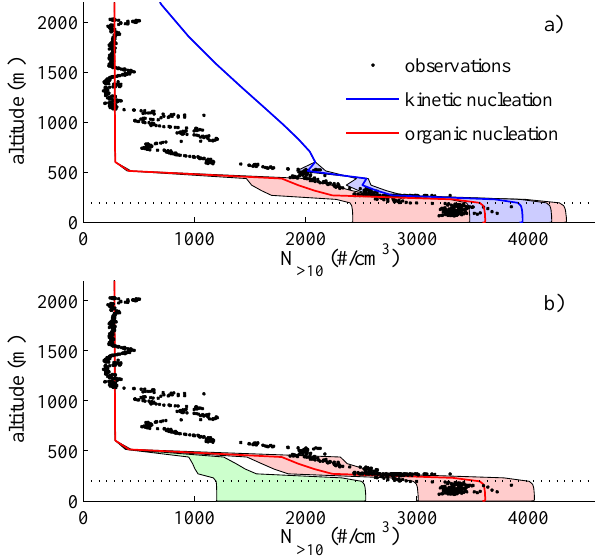
Fig. 3. Observed and simulated particle number concentration N > 10nm on 13 March 2006 when the particles are formed by or- ganic and kinetic nucleation. The ABL height is shown by black dotted horizontal line. (a) The shaded areas show the range of concentration when reaction rate of organics is multiplied by 0.2– 1. (b) The shaded areas show the range of particle concentration when 2–10% of organic vapours can condense on particles (red) and when (i) organics are nonvolatile, (ii) organics are nonvolatile and P = 10 − 3 cm − 3 or (iii) organics cannot condense on particles below 3nm (green).